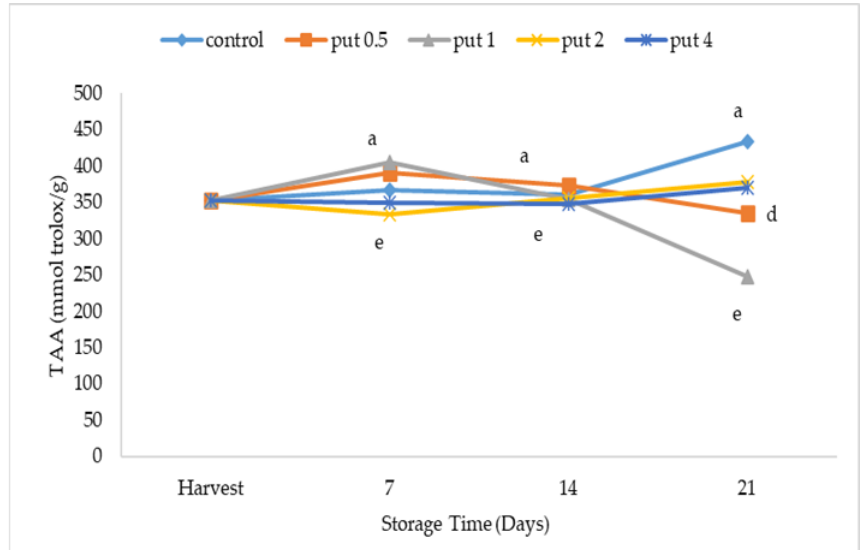
Figure 7. Effect of putrescine treatment on total antioxidant activity (TAA) of fig fruit during cold storage. put 0.5, 1, 2 and 4 indicates putrescine doses of 0.5 mM, 1 mM, 2 mM, and 4 mM, respectively. According to the Tukey test, p < 0.05 does not differ between the same letters in the same harvest period.